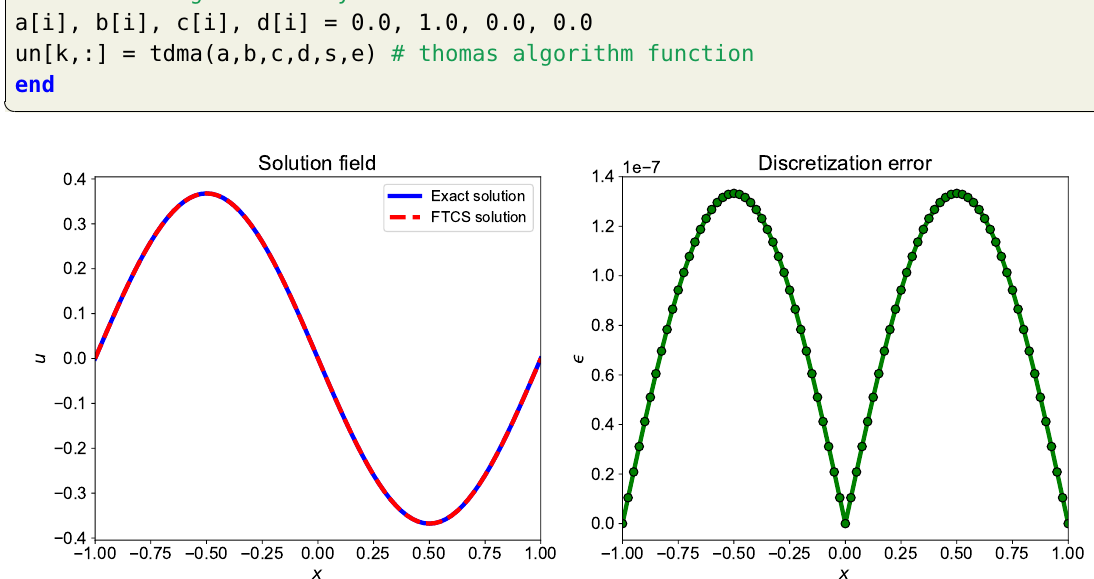
Figure 5. Comparison of exact solution and numerical solution computed using implicit compact Pade numerical scheme. The numerical solution is computed using ∆ t = 0.0025 and ∆ x =